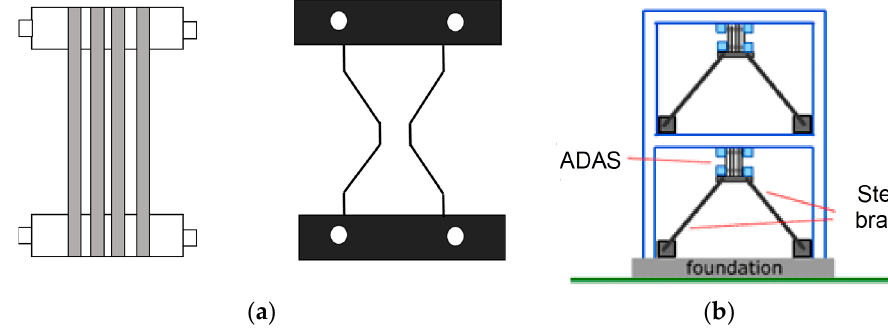
Figure 9. ( a ) Description of ADAS damper, ( b ) two story frame with ADAS